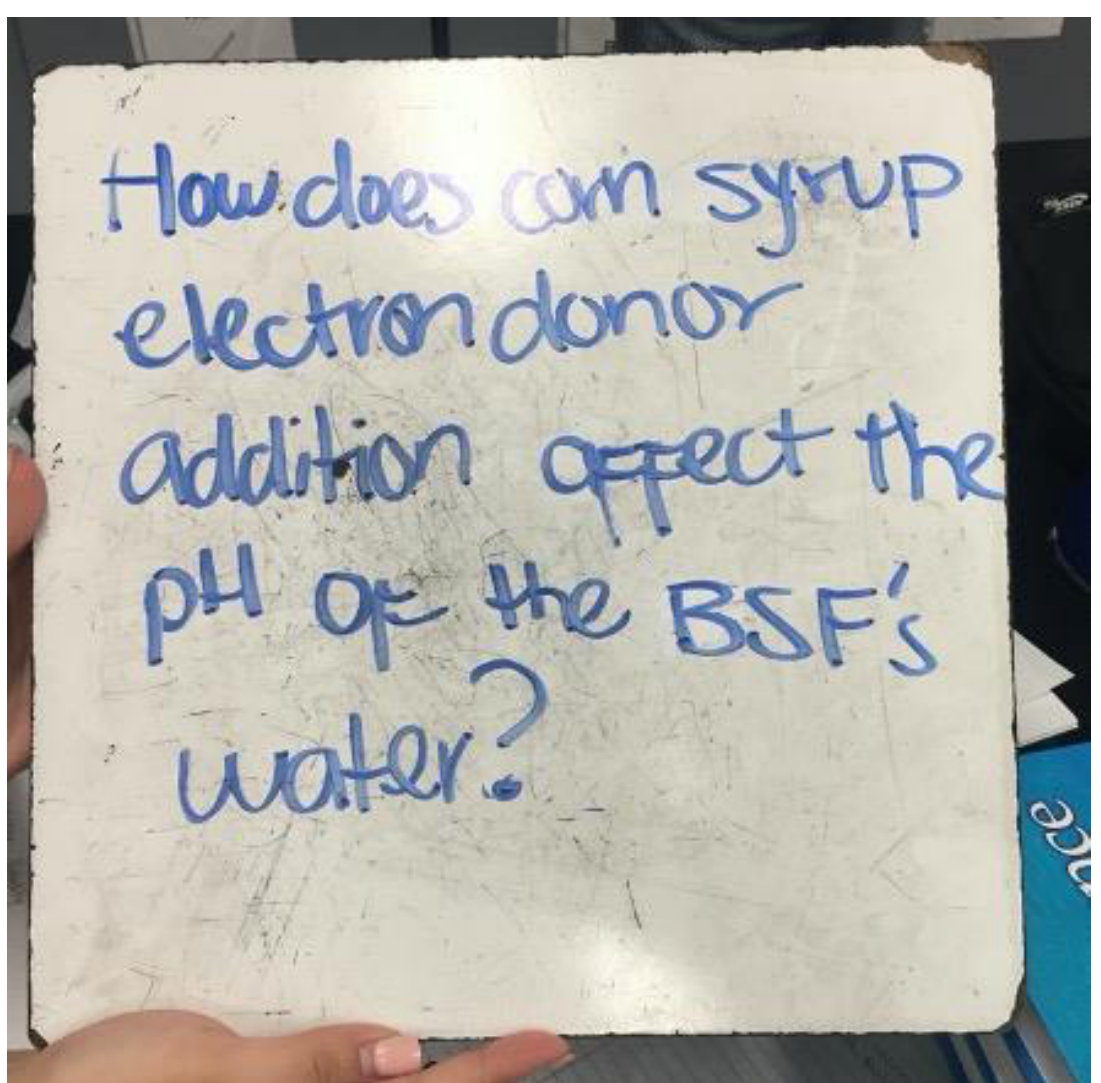
Figure 5. Student generated research question displayed on a whiteboard.